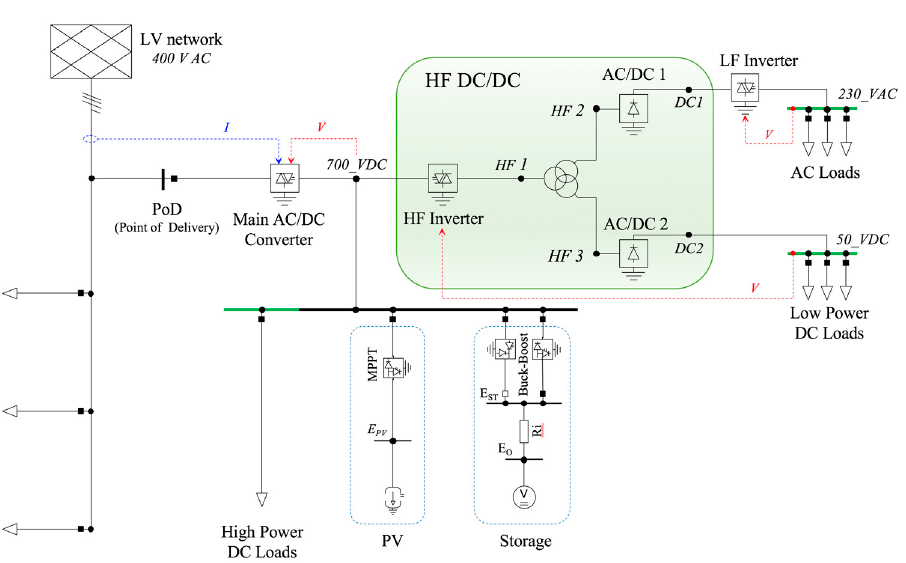
Figure 2. Detailed topology of the AC/DC hybrid configuration resulting from a preliminary design procedure, including the electric scheme, voltage levels and converter types.